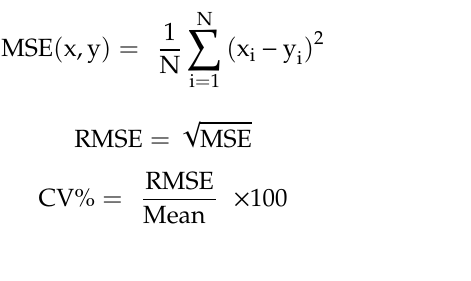
Figure 5. The general layout of the optimization process using the genetic algorithm (GA). The error values were represented in terms of MSE (mean square error), RMSE (root mean square error), and or CV% (coefficient of variation), were those described in the following equations.